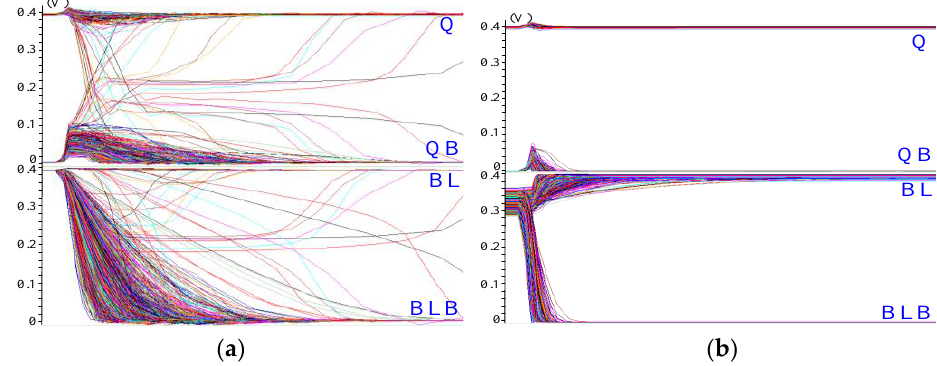
Figure 6. 10,000 times read Monte Carlo post-simulations at 400 mV ( a ) Result of (conv.) 6 T SRAM. ( b ) Result of proposed local bit-line SRAM.